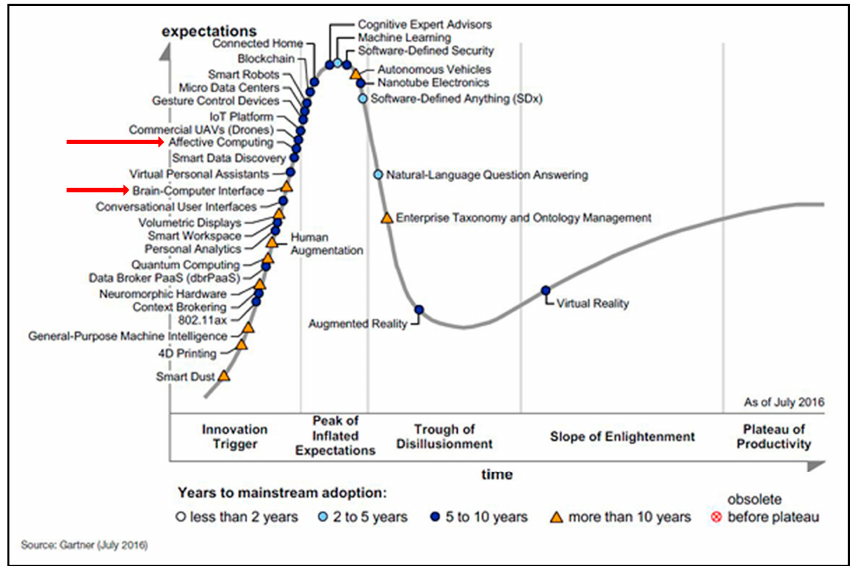
Figure 1. Gartner Hype Cycle for Emerging Technologies 2016; Brain-computer interface and affective computing are noted by the arrows (Source: Gartner’s 2016 Hype Cycle for Emerging Technologies, http://www.gartner.com/newsroom/id/3412017).